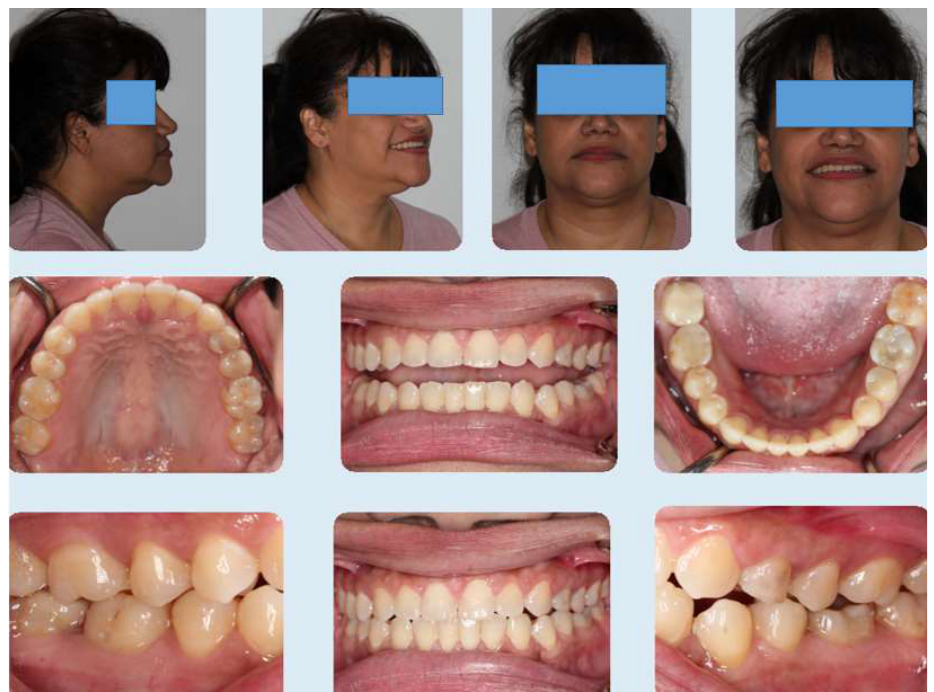
Figure 8. Final photos showing improvement in the patient’s initial chief complaints including open bite and spacing as well as cross bite.